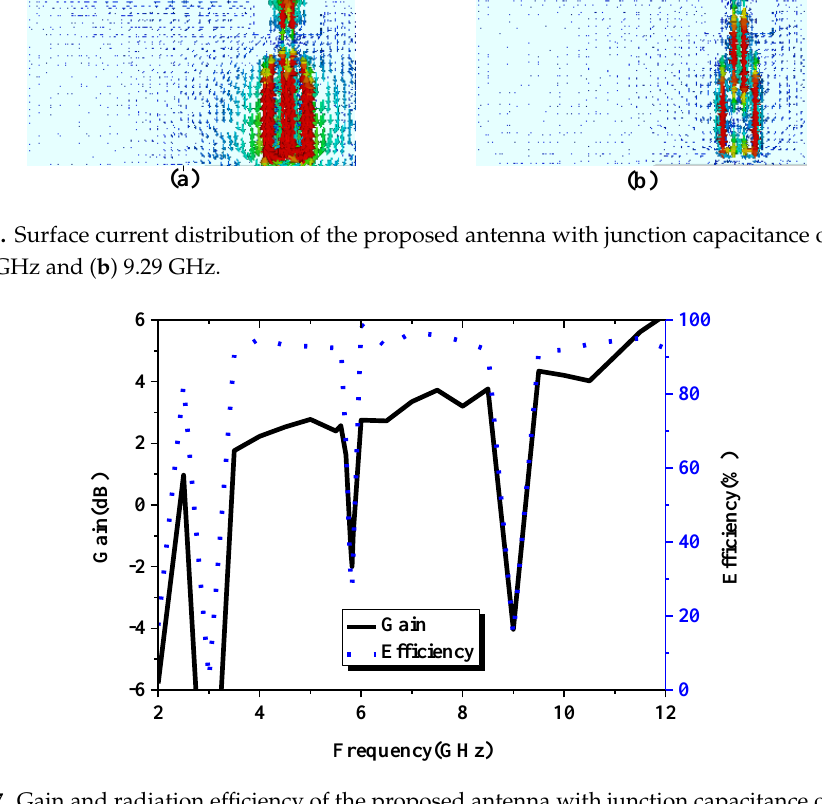
Figure 7. Gain and radiation efficiency of the proposed antenna with junction capacitance of 0.63 pF.